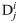
A gene expression block.A GRN that consists of gene expression blocks. A block consists of a gene reactions block and a protein reactions block. The gene reactions are described in the text. TF is a vector of TFs which can be monomers, dimers, or higher order multimers. Di is a vector whose components consist of the Dji’s. The dimension of TF is equal to the number of binding sites of the gene.